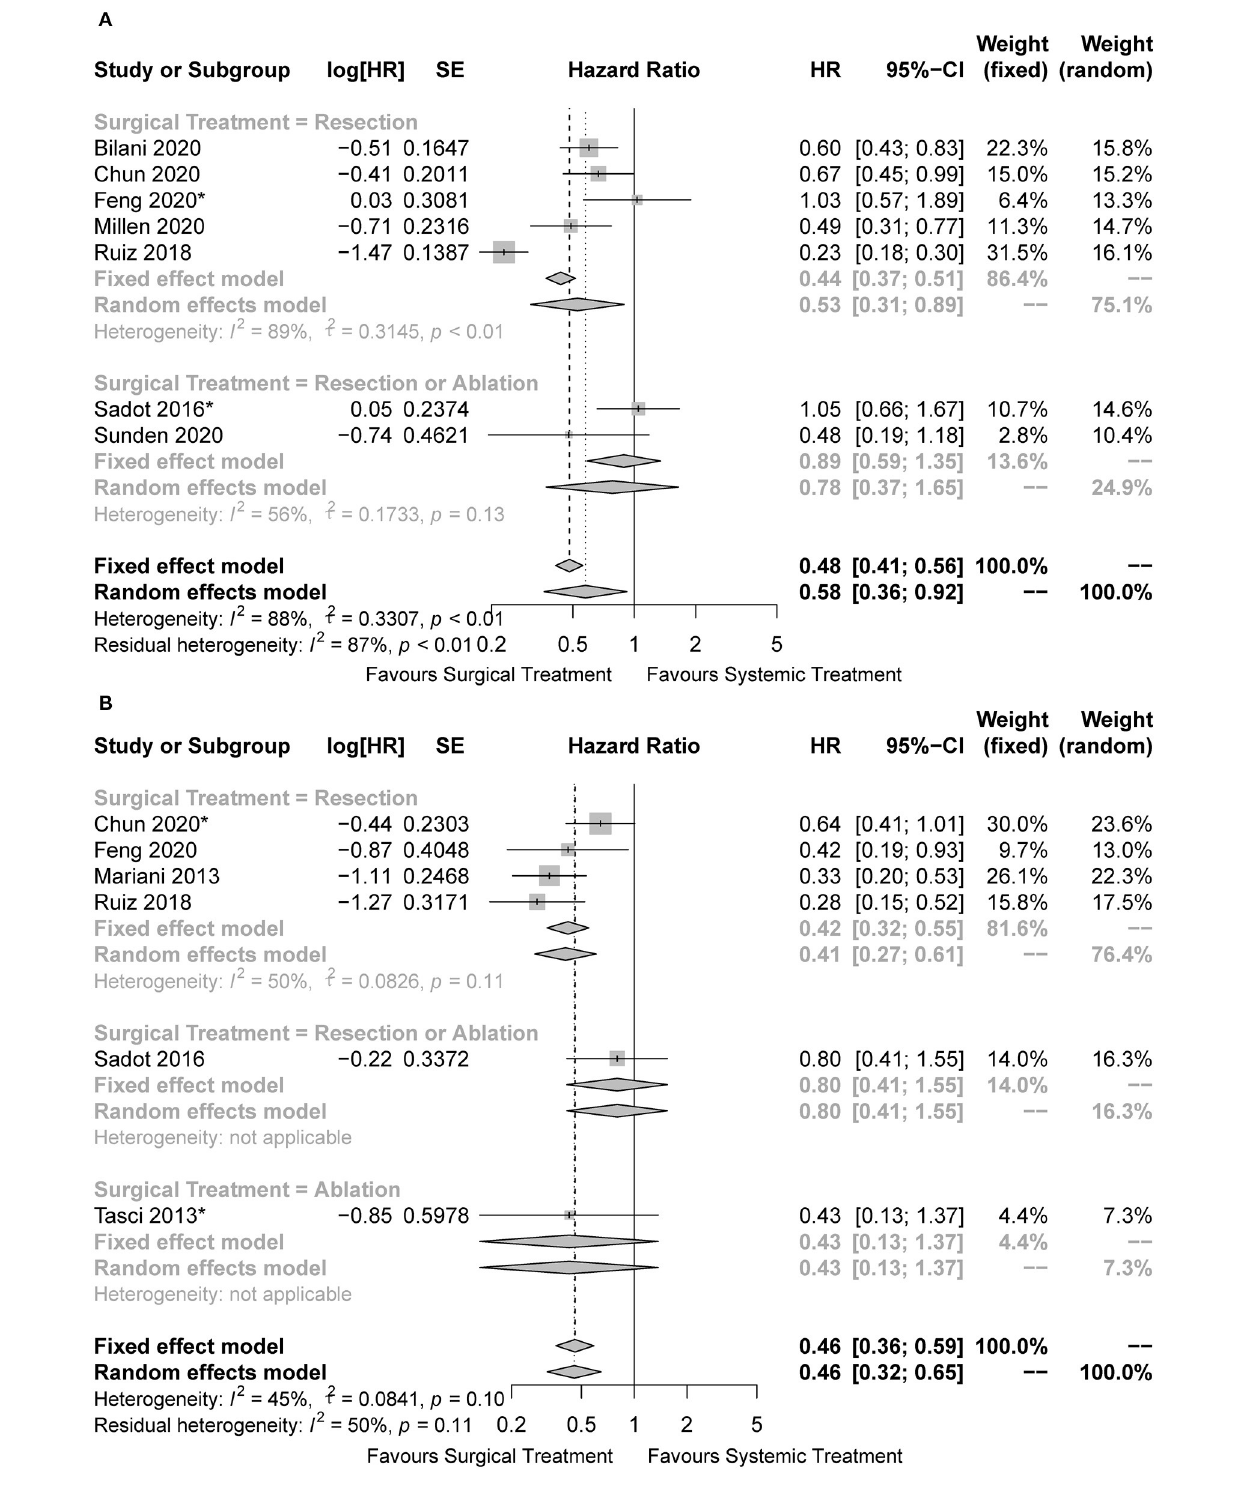
FIGURE 3 | Forest plots for comparison of overall survival between surgical and systemic cohorts in (A) unmatched cohorts and (B) matched cohorts. *The hazard ratio was estimated from the survival curves.